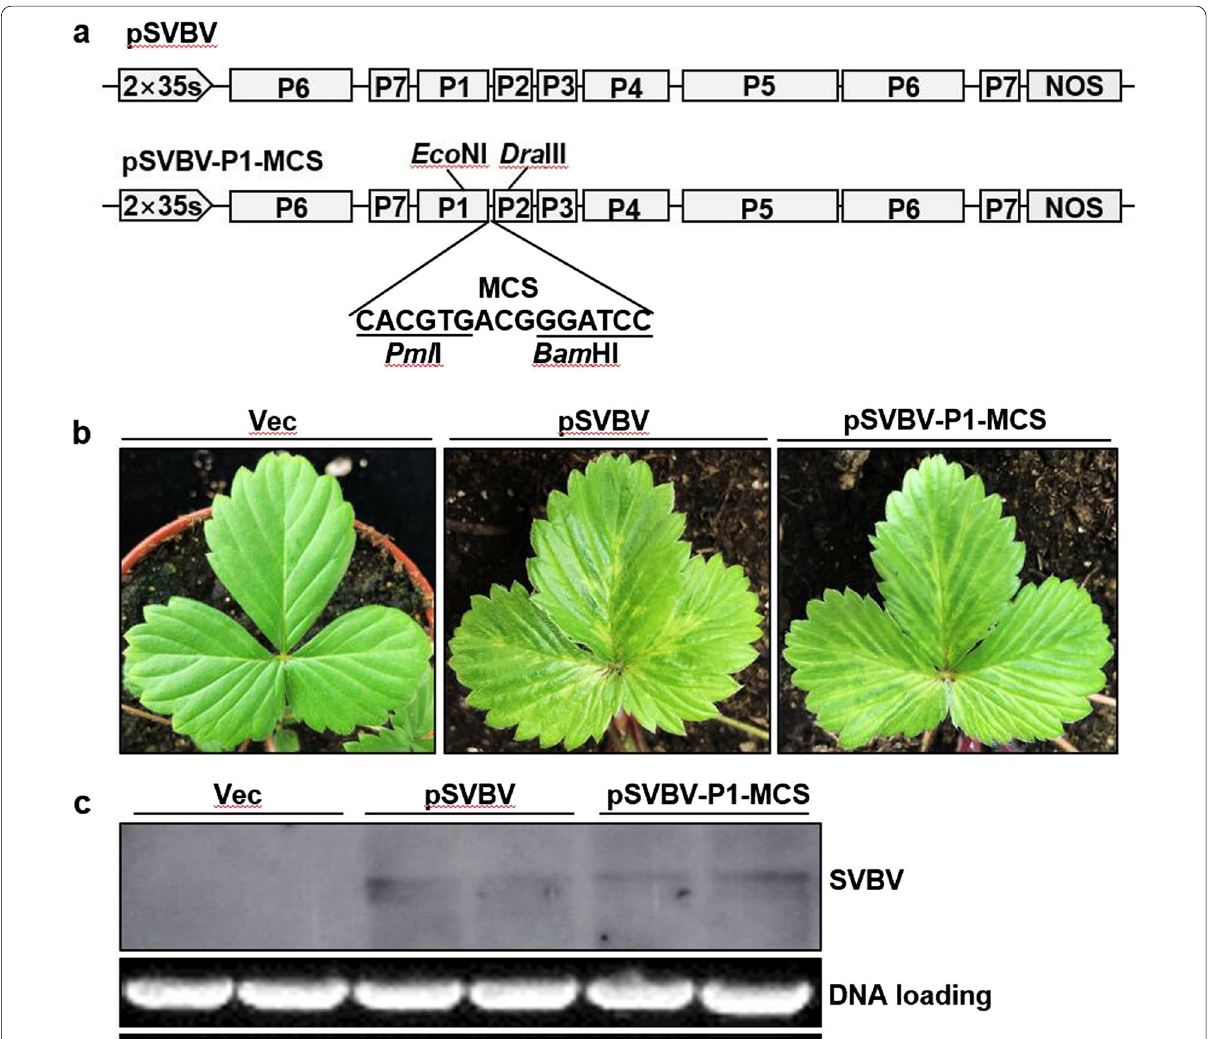
Fig. 1 The recombinant virus vector pSVBV-P1-MCS could induce systemic infection in strawberry plants. a Schematic representation of the construction of pSVBV and pSVBV-P1-MCS vector. A total of 1.25 copies of the full-length SVBV genome were inserted into pCB301 to construct the infectious clone pSVBV. The MCS sequence was CAC GTG ACG GGA TCC , with the underlined part representing the recognition sequence of restriction endonucleases Pml I and Bam HI. Fragment P1-MCS was cloned into the plasmid pSVBV via the Eco NI/ Dra III to generate pSVBV-P1-MCS, which has a MCS downstream of the P1 gene; b Light-green vein banding symptoms were observed in systemic leaves of strawberry plants agroinfiltrated with pSVBV or pSVBV-P1-MCS. Strawberry plants agroinfiltrated with pCB301 were used as negative controls; c Accumulation of SVBV in pCB301-, pSVBV-, or pSVBV-P1-MCS-agroinfiltrated strawberry plants determined by Southern blot analysis. Blot was probed with the CP gene sequence of SVBV. The lower panel represents an ethidium bromide-stained gel of DNA samples as a loading